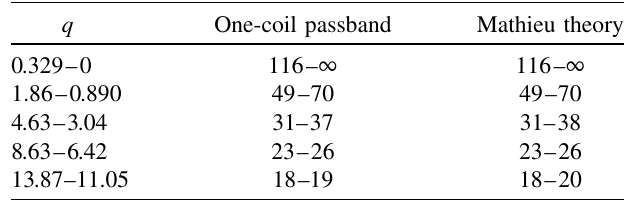
TABLE II. Momentum passband locations [ MeV =c ].